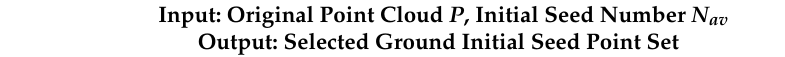
Table 1. Ground initial seed point selection algorithm.